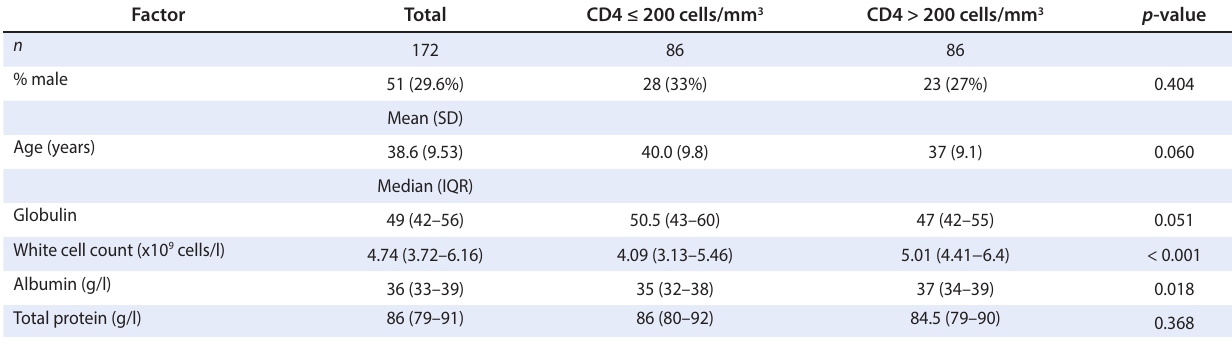
Table 1: Demographics and the investigated variables between the two CD4 threshold cohorts Factor